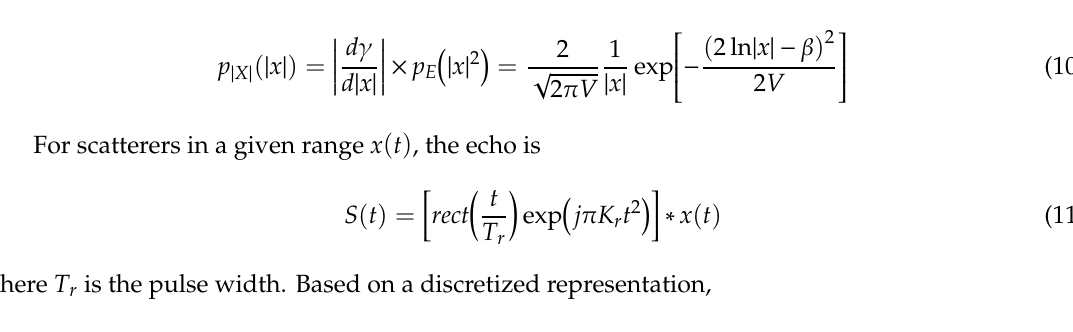
Figure 10. Statistical result for containers. ( a ) The saturated area with isolated large dynamic range objects. ( b ) Fitting result for the energy associated with the containers. The two spikes at ln γ = 20.8 and ln γ = 21.5 are caused by the quantization threshold of the 16-bit complex image. √ γ obeys the following relation. The amplitude of the scatterers | x | =